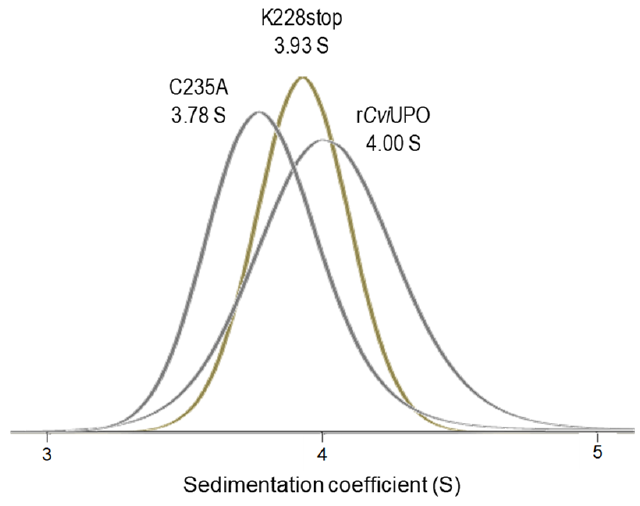
Figure 5. Sedimentation coefficients of native r Cvi UPO and its K228stop and C235A variants (from sedimentation velocity profiles in Figure S3). The estimated molecular masses were in the range of 57–66 kDa, revealing dimeric proteins in all the cases.